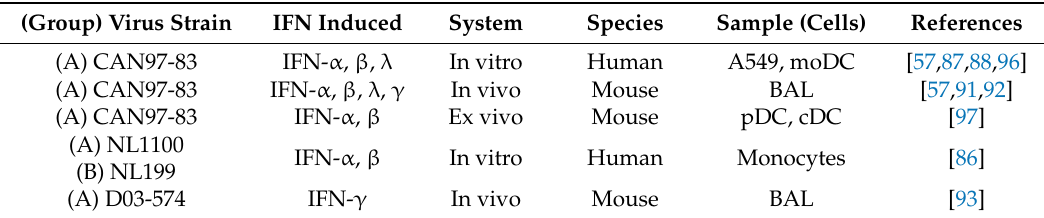
Table 1. Type of IFNs induced by different HMPV